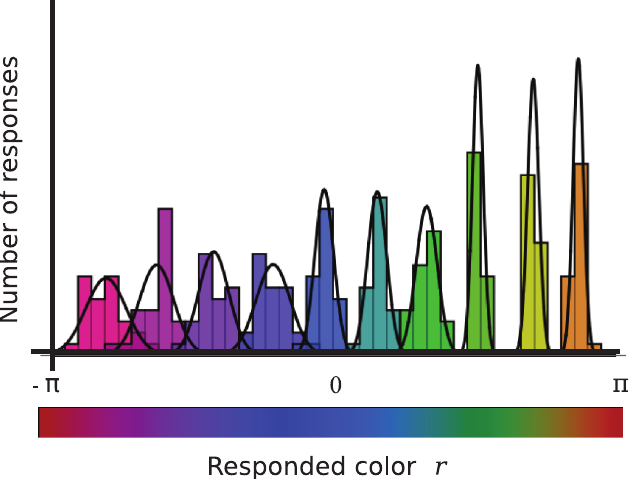
Fig 2. Histograms of responses conditional to a fixed target color. A subset of 10 histograms (out of the tested 32, one per target color) obtained when sampling the probability P ( r | t )of responding color r when presented with target t . Each curve is obtained for a different t , for a subject who played the game 26